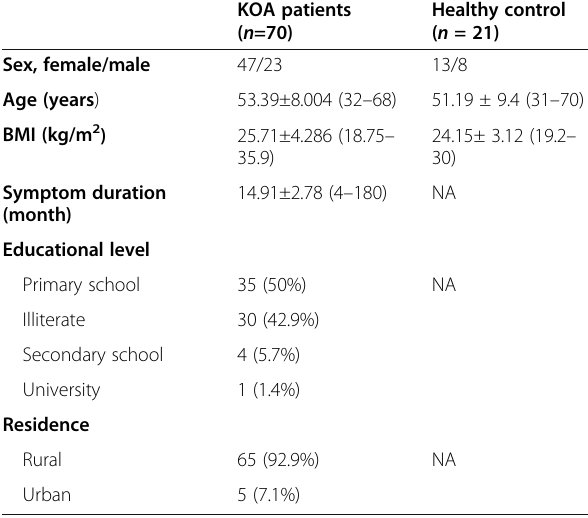
Table 1 Sociodemographic data of the studied population KOA patients ( n =70)